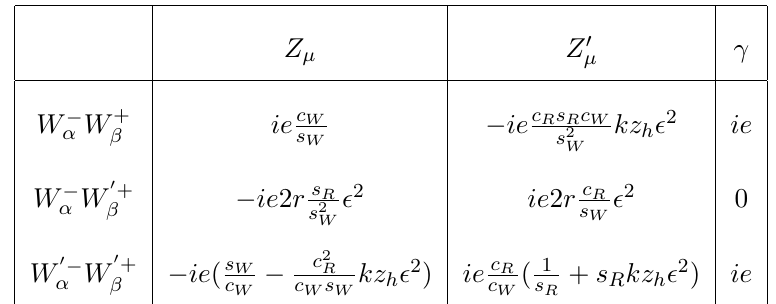
Table 15 . Triple gauge couplings involving either one Z or one Z 0 boson. These couplings have to be multiplied by g (cid:11)(cid:12) ( p + (cid:0) p (cid:0) ) (cid:22) + g (cid:22)(cid:12) ( q (cid:0) p + ) (cid:11) + g (cid:22)(cid:11) ( p (cid:0) (cid:0) q ) (cid:12) where ( p + , p (cid:0) , q ) are the incoming momenta of the positively, negatively charged and neutral particles respectively.